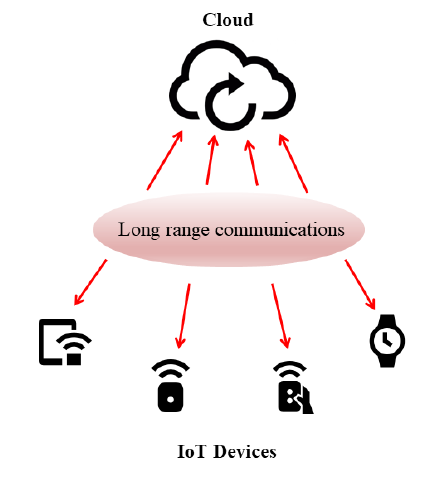
Figure 1. Typical IoT scenario where multiple devices are directly connected to the Cloud in a LPWAN.